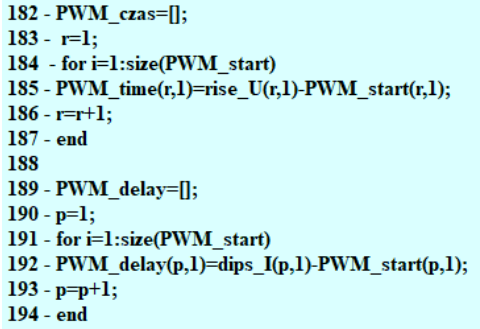
Figure 6. Assigning the time-ranges spotted by the algorithm.